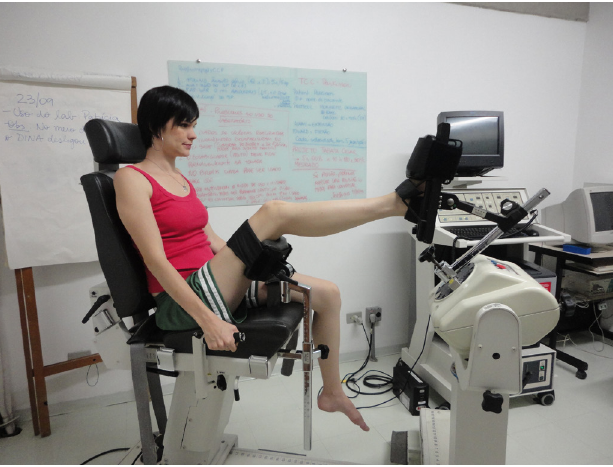
Figure 1. Positioning of the participant at the isokinetic dynamometer with the foot resting on the support plate of the